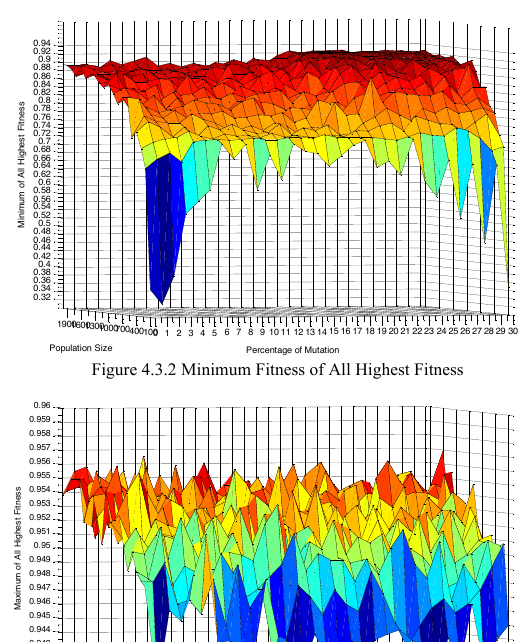
Figure 4.2.1 Mean Fitness of All Highest Fitness